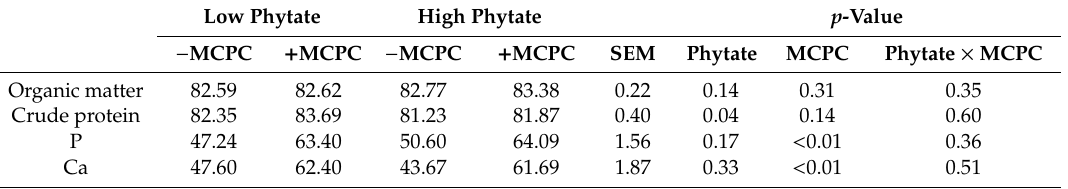
Table 2. E ff ects of phytate level and enzymes on the AID of nutrients 1 .